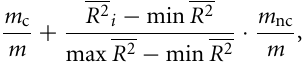
(listed on the y -axis) are given for the methods under